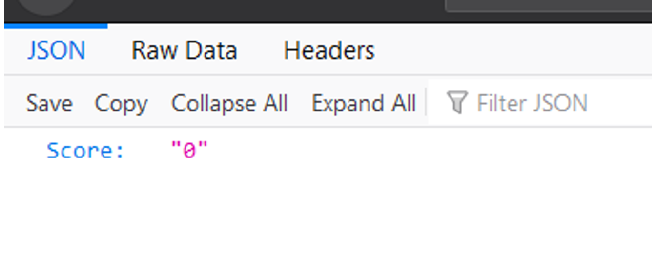
Figure 6. Output JSON